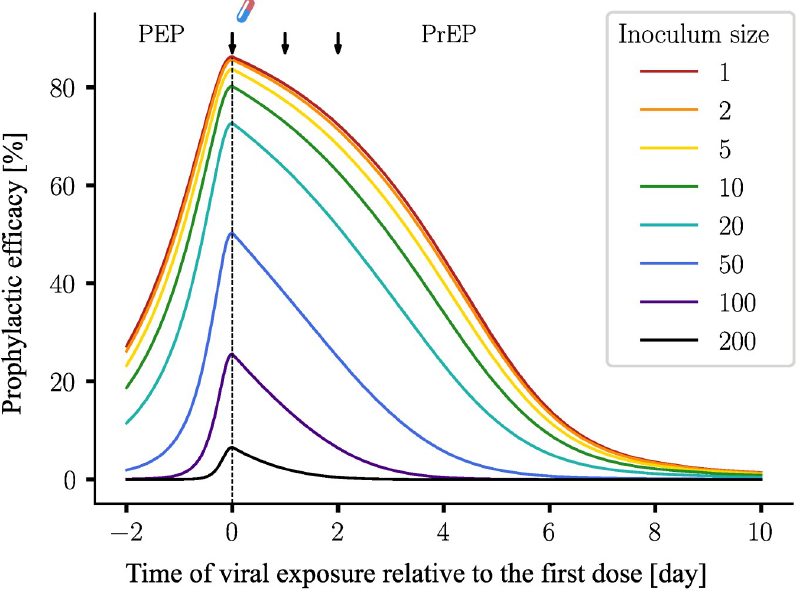
Fig 5. Profiles of prophylactic efficacy for different inoculum sizes. The experimental setup was chosen identical to Fig 3. To calculate the prophylactic efficacy profiles, an exponential scaling is applied to the solutions of the PGS (Eq (3)). The solutions are plugged into Eq